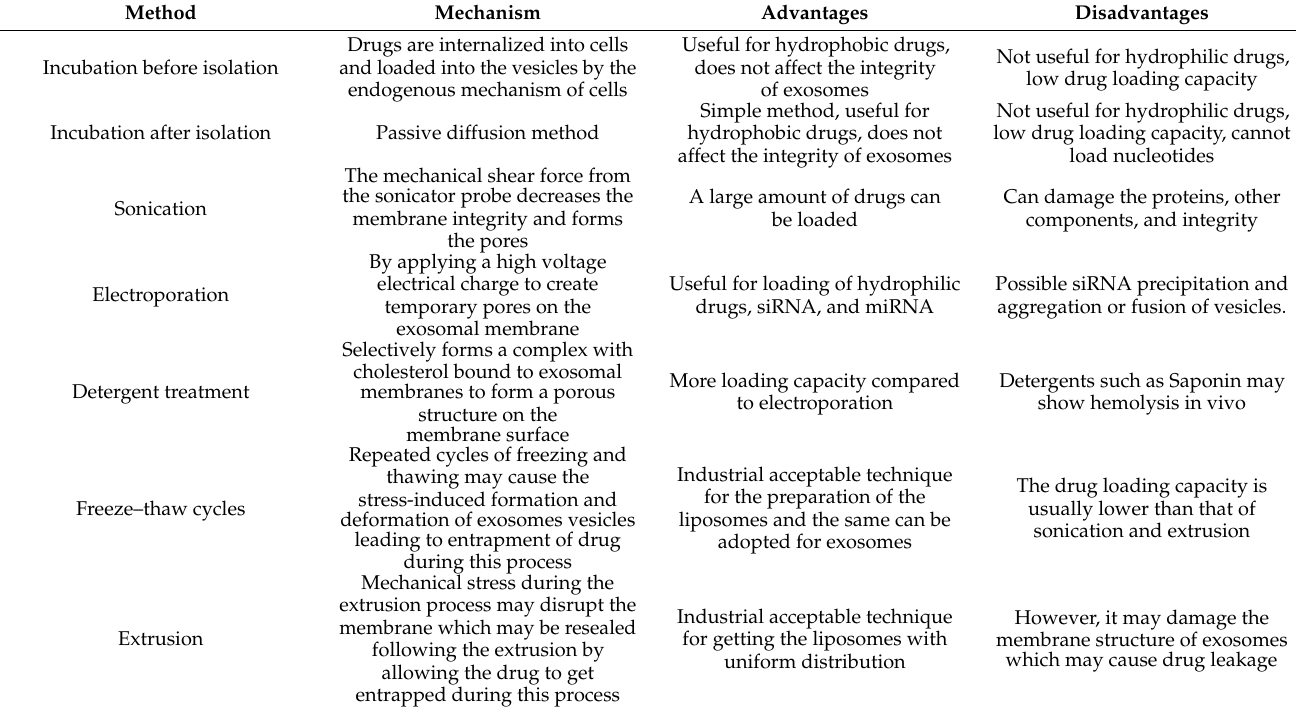
Table 4. Summary of different drug loading